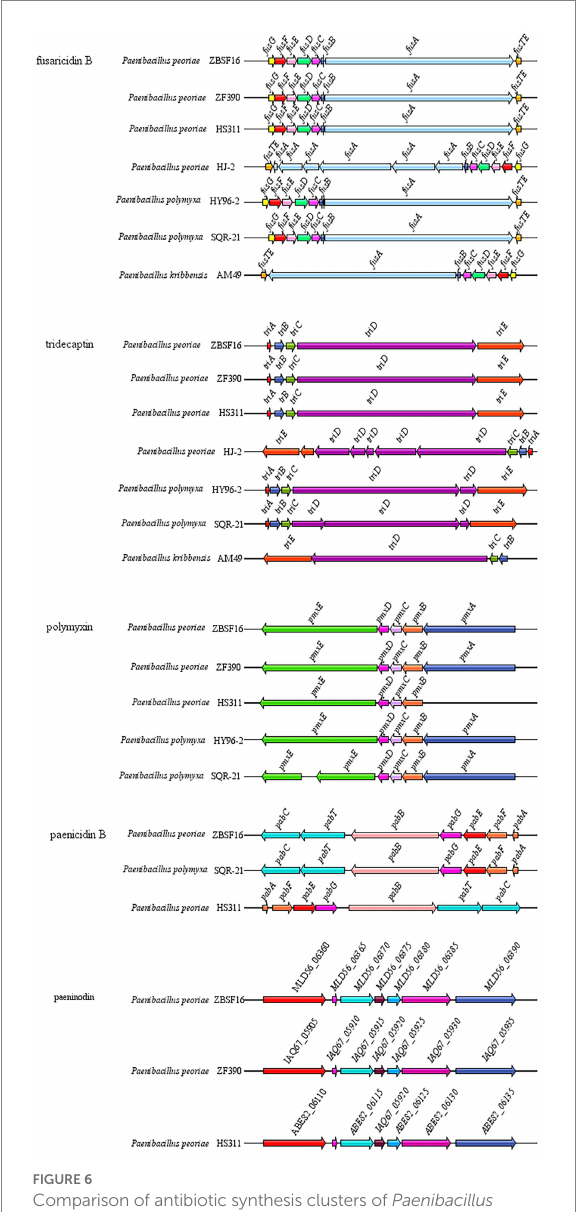
FIGURE 6 Comparison of antibiotic synthesis clusters of Paenibacillus strains. Antibiotic synthesis clusters were identified using antiSMASH, and gene cluster intraspecific genes were